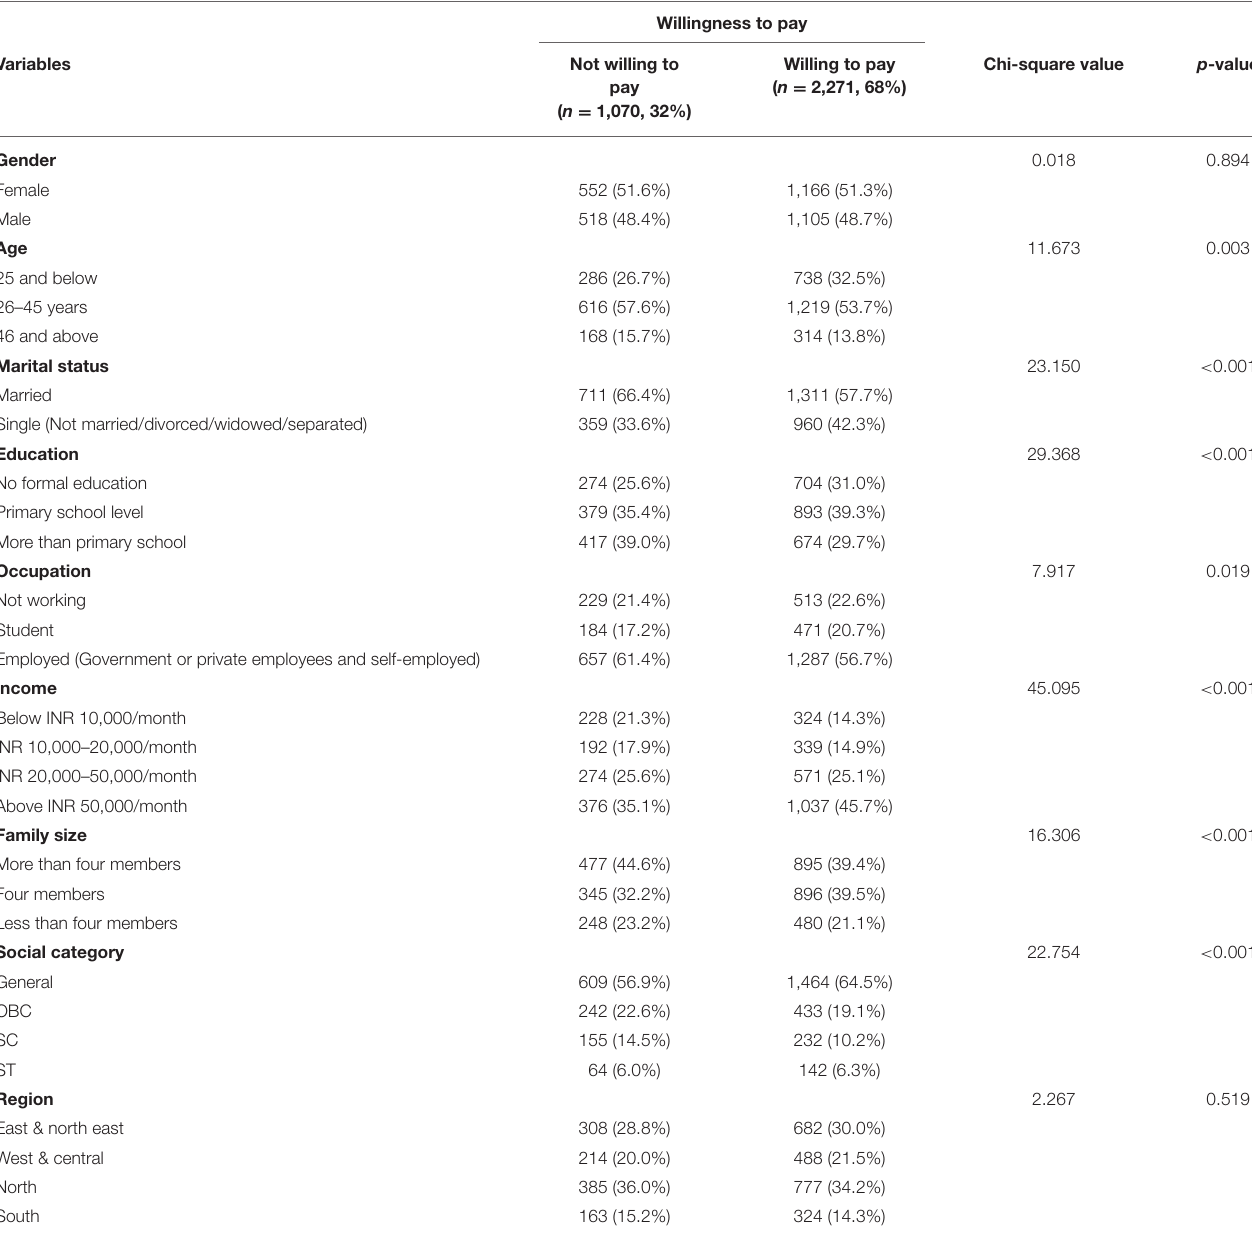
TABLE 2 | Bivariate analysis between sociodemographic characteristics and willingness to